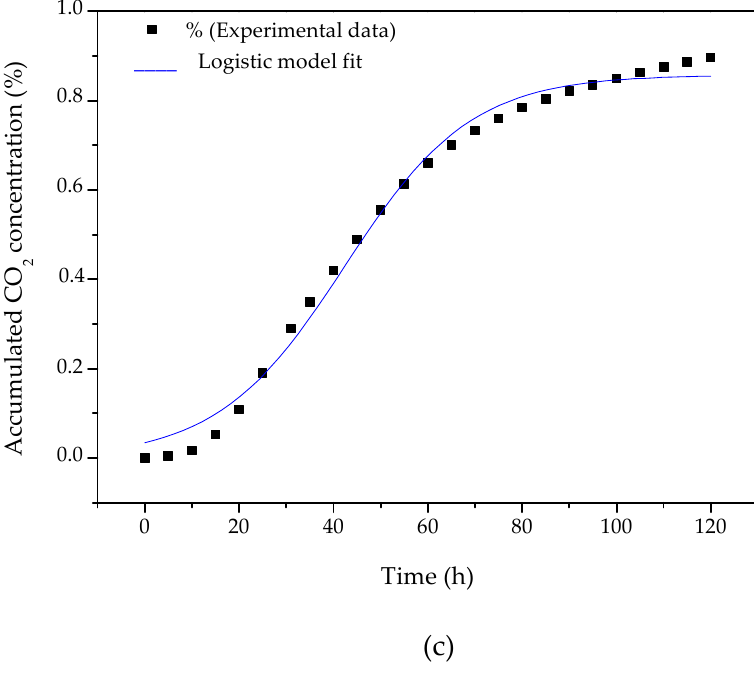
Figure 3. SSF for 120 h in the column bioreactor with A. niger F12 at 32 °C and pH 6.0. ( a ) Time-course curves for accumulated CO 2 (left-hand y-axis) and β -mannanase activity (right-hand y-axis); ( b ) correlation curve; ( c ) logistic model